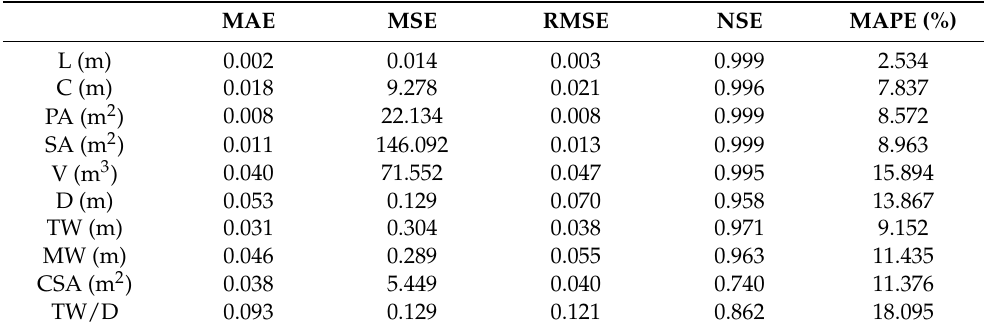
Figure 6. Linear relationships between gully morphological characteristics measured by RTK and UAV (n = 30). Table 2. Errors of gully morphological characteristics measured by RTK and UAV (MAE, mean absolute error; MSE, mean squared error; RMSE, root-mean-square error; NSE, Nash–Sutcliffe efficiency coefficient; MAPE, mean absolute percentage error).